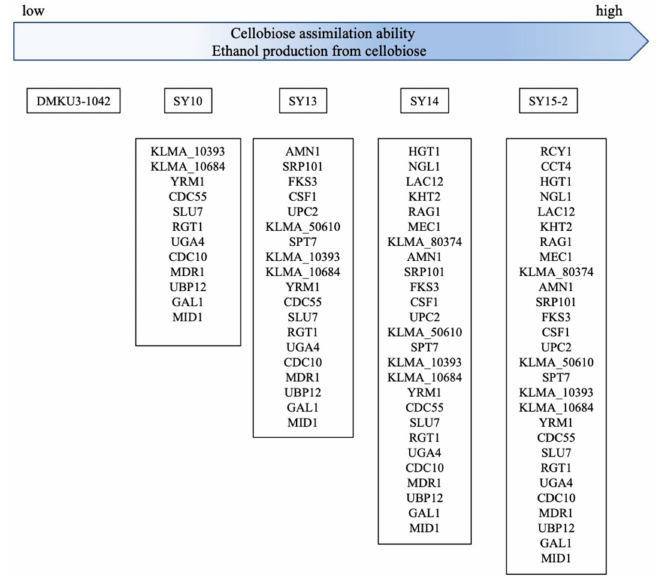
Figure 3. Mutations in mutants and their transfer from SY10 to its descendants. Mutations that cause amino acid substitutions, insertion or deletion of amino acids and frame shifts in SYs are shown. The relative abilities of cellobiose assimilation and ethanol production from cellobiose in SYs are shown at the